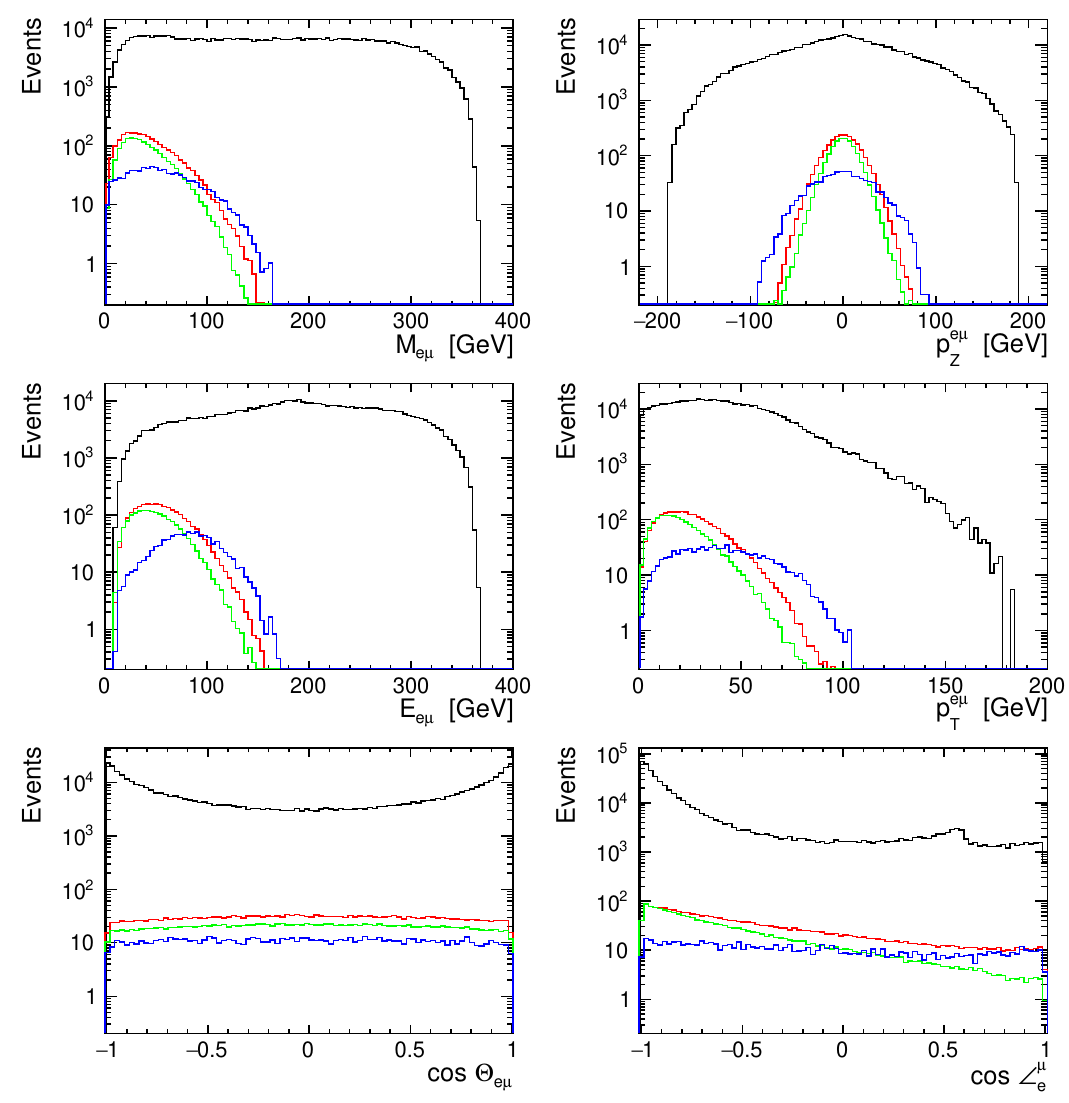
Figure 7 . Distributions of the kinematic variables describing the leptonic (cid:12)nal state considered in H + H (cid:0) analysis: lepton pair invariant mass, M e(cid:22) , total longitudinal momentum, P e(cid:22) , lepton pair Z energy, E e(cid:22) , total transverse momentum, P e(cid:22) , pair production angle, (cid:2) e(cid:22) and the angular distance T between the two leptons, cos \ (cid:22) . Expected distributions for BP1 (red histogram), BP3 (green) e and BP6 (blue) are compared with expected background (black histogram). Samples simulated for CLIC running at 380 GeV are normalised to 1 ab (cid:0) 1